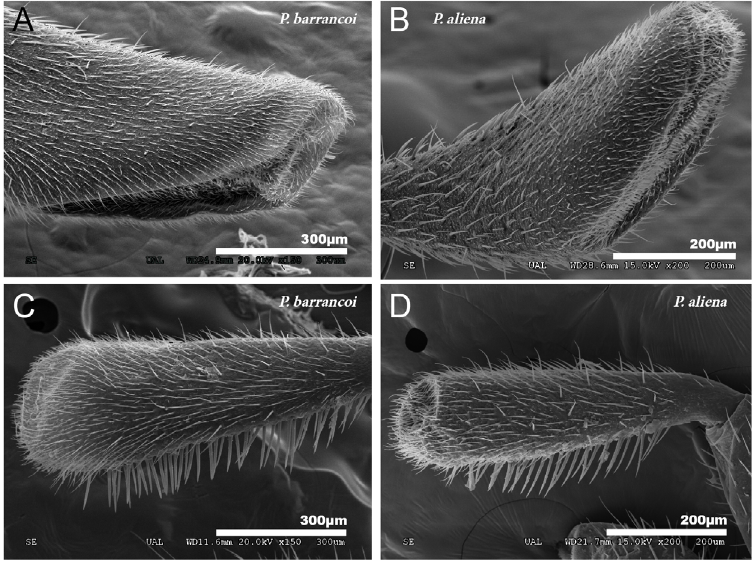
Table 4. Degree of troglomorphism in the genus Petaloptila. The values of PF/LP, TP/LP, HH/HE, HE/WE, and LP/HH are mean ± S.D. PF/LP and TP/LP are ratios used to assess appendage elongation (PF, hind femur length; PL, pronotum length; PT, hind tibia length); HH/HE and HE/WE to assess ocular size reduction (HH, head height; WE, eye width; EH, eye height); LP/HH to assess cephalic elongation. The differences in the structures on Zapetaloptila and Petaloptila were determined using Kruskal-Wallis test. Mean values with different superscripts within the same column and for the same parameter indicate statistically significant differences ( p -value ≤ 0.05). Species